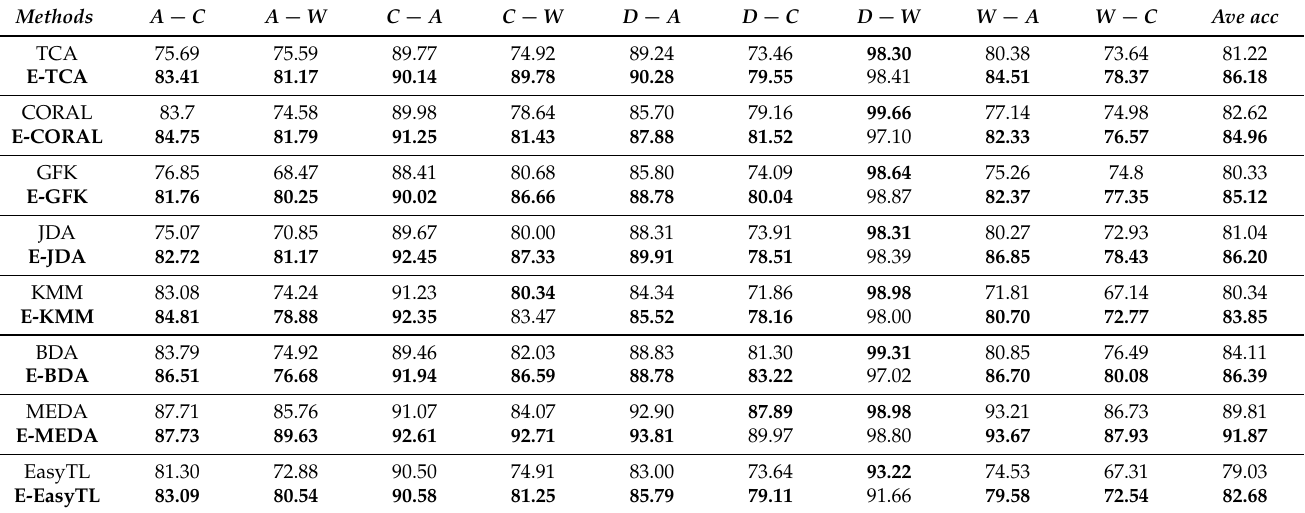
Table 5. Cross-domain classification accuracies of Office+Caltech image data sets generated by the traditional TL methods with and without ensemble